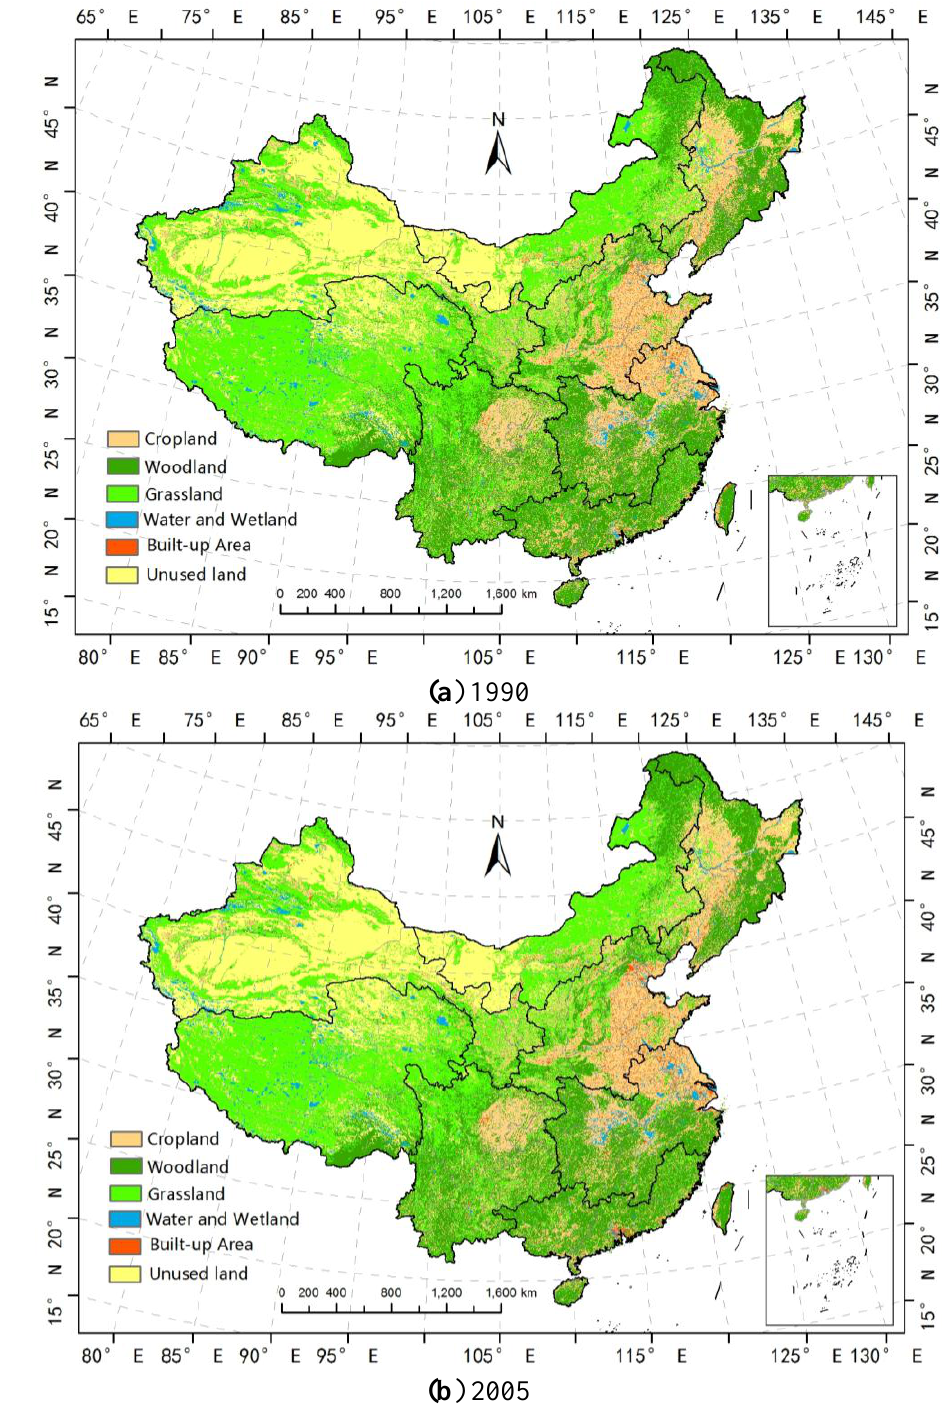
Figure 9. Land-cover in China: 1990 ( a ) and 2005 ( b